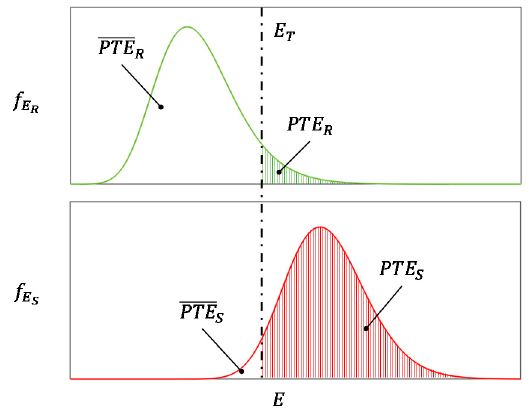
Figure 1. PDF of the interpolation error f ( E ) in the reference ( R ) and in the inspection states ( S